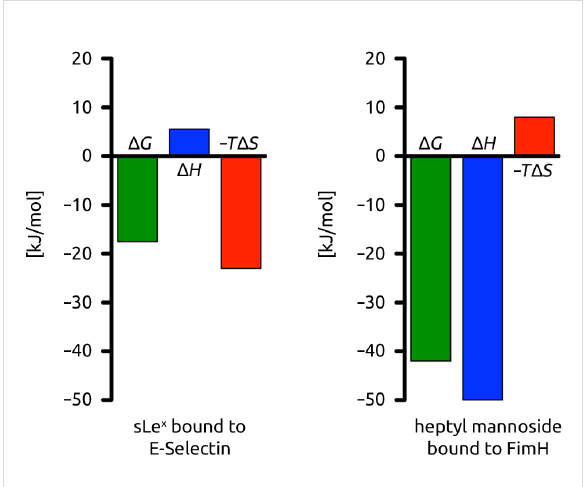
Figure 6: Thermodynamic fingerprints of sLe x bound to E-selectin and n -heptyl α -D-mannoside bound to FimH LD ( I ). The sLe x –E-selectin interaction is entropically driven, whereas the n -heptyl α -D-manno- side–FimH LD ( I ) is enthalpically